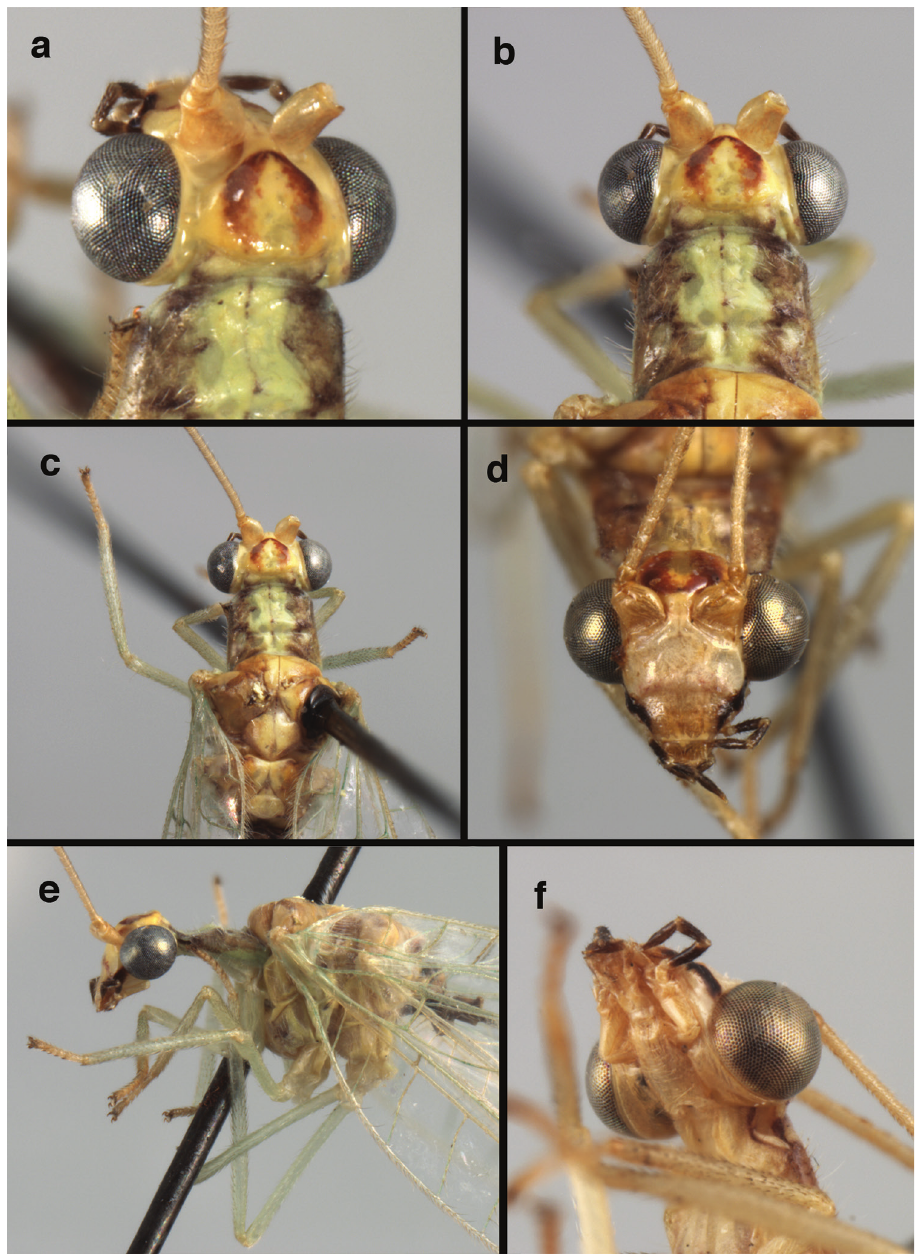
Figure 130. Ungla elbergi Tauber, sp. n. External features, ( a ) head, dorsolateral [Note marking in an- tennal fossa.] ( b ) head, prothorax, dorsal ( c ) head, thorax, dorsal ( d ) head, frontal ( e ) head, thorax, lateral ( f ) head, ventrolateral (Argentina; a–c, e La Rioja, paratype, female, EMEC; d, f Tucumán, holotype, male,